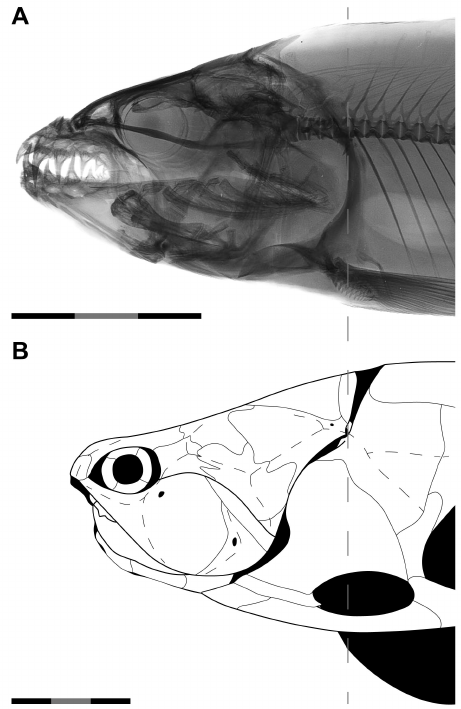
Figure 8. X-ray of Hydrocynus forskahlii (( A ), CAS SU 63349; [144]) and Coccosteus cuspidatus (( B ), modified from [15]) scaled to the same neurocranial length, showing how arthrodires have proportionally shorter snouts than other fishes. Note how the neurocranium of the two taxa is similar in shape but the head of H. forskahlii is slightly longer due to the more prognathic mouthparts of this taxon. Scale = 3